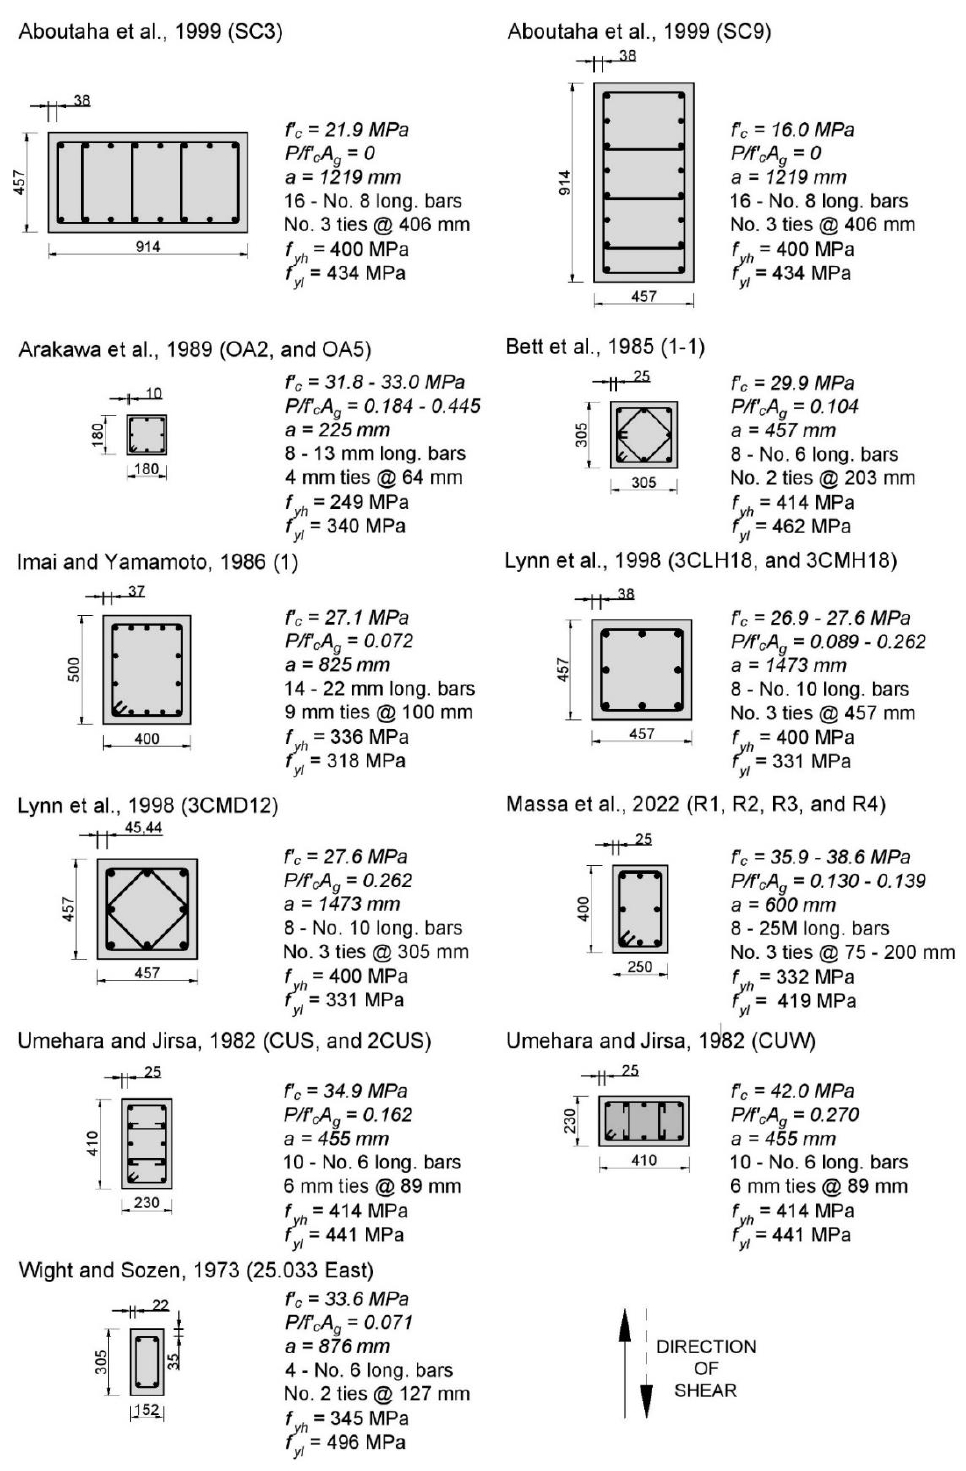
Figure 2. Shear-critical rectangular columns investigated with reversed-cyclic shear applied in the direction as shown. Adapted from [11 – 17,25].